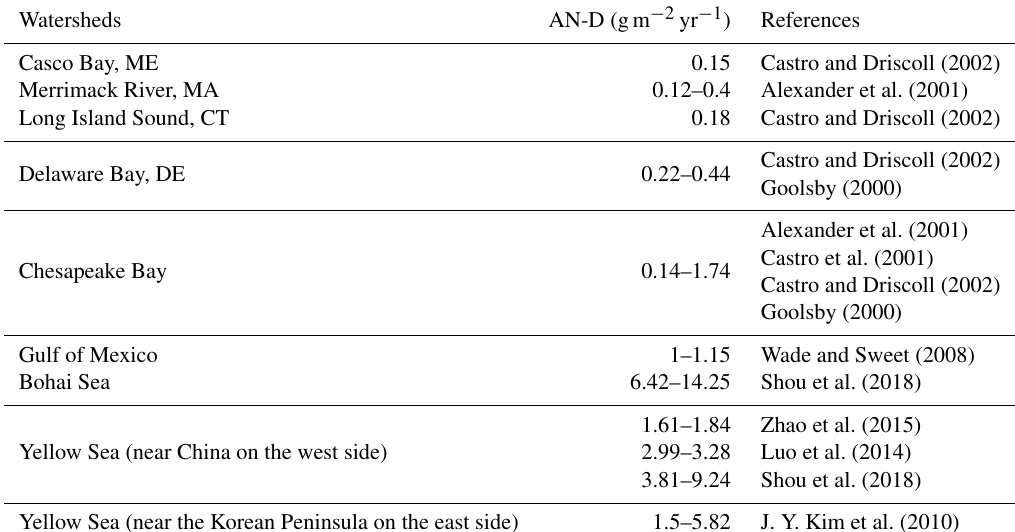
Table 2. Atmospheric nitrogen deposition (AN-D) in the USA and in the Yellow Sea.